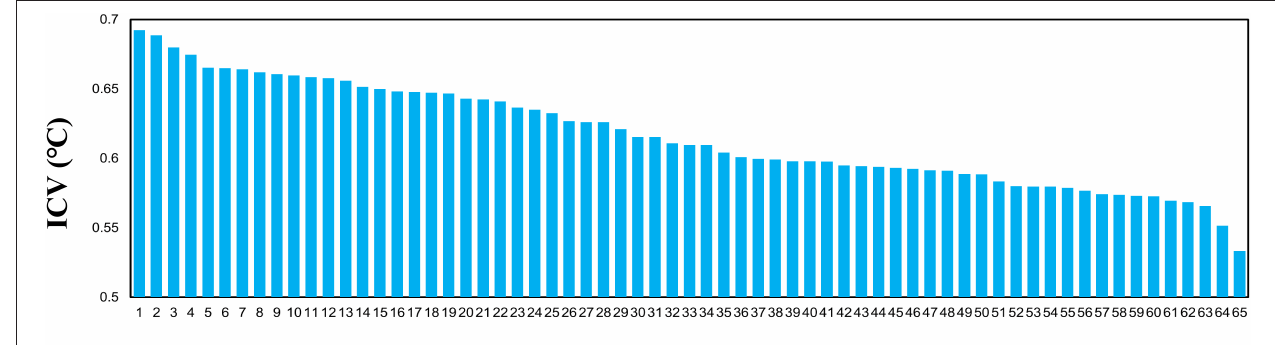
FIGURE 2 | The ICV simulated in 65-ensemble members including both CESM-LENS and GFDL-LENS simulations during the present climate (1960–2010). Each blue bar represents the ICV simulated by each ensemble member during the present climate, ranked by the intensity of ICV from the strongest to the weakest among 65-ensemble member (1–65). Unit is ◦ C.